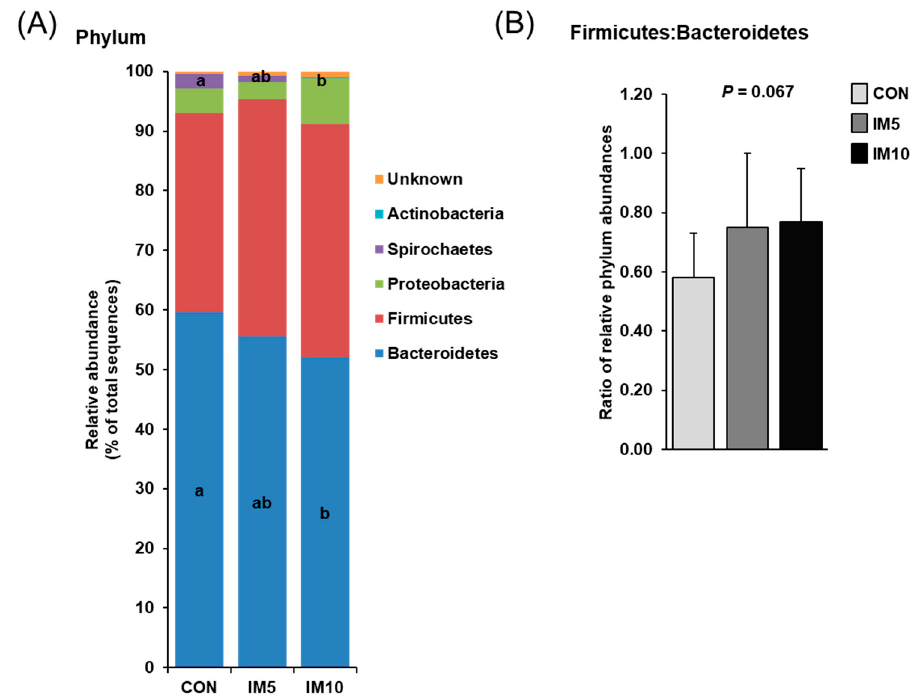
Figure 3. Effect of dietary treatment on cecal microbiota composition in pigs fed isonitrogenous diets without (CON) or with 5% (IM5) or 10% Tenebrio molitor larvae meal (IM10) for four weeks. ( A ) Distribution of cecal bacteria at the phylum level; ( B ) Ratio of the relative abundances of the two main phyla, Bacteroidetes, and Firmicutes. Values are means ± SD for n = 10 pigs per group. a,b Values with different superscripts differ significantly at p < 0.05. Table 3. Bacterial population composition (genus level) in the cecal digesta of pigs fed isonitrogenous diets without (CON) or with 5% (IM5) or 10% Tenebrio molitor larvae meal (IM10) for four weeks.